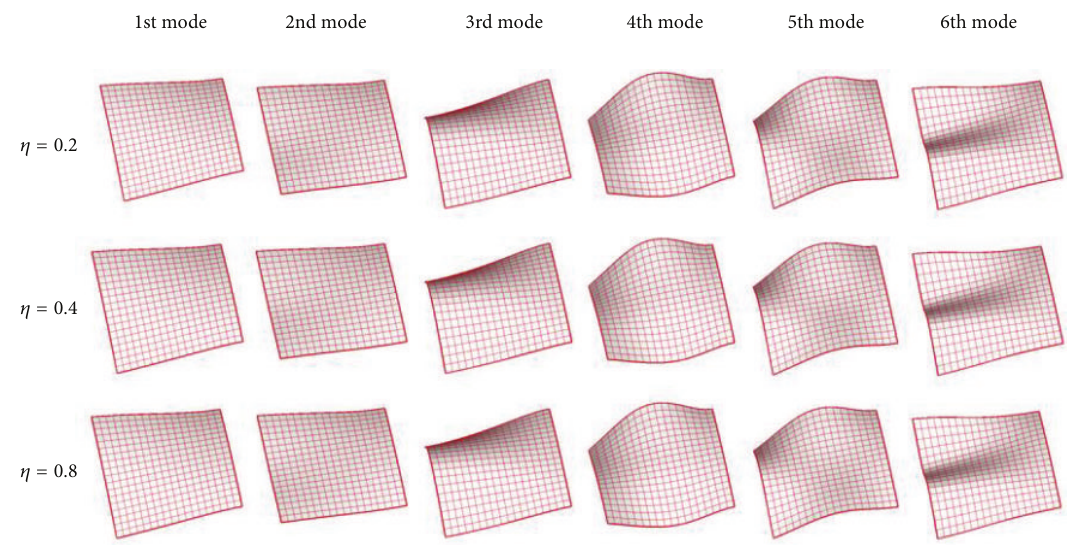
Figure 4: Mode shapes of fiber reinforced cylindrical composite panel with variation of damping ratio 𝜂 of viscoelastic layer.